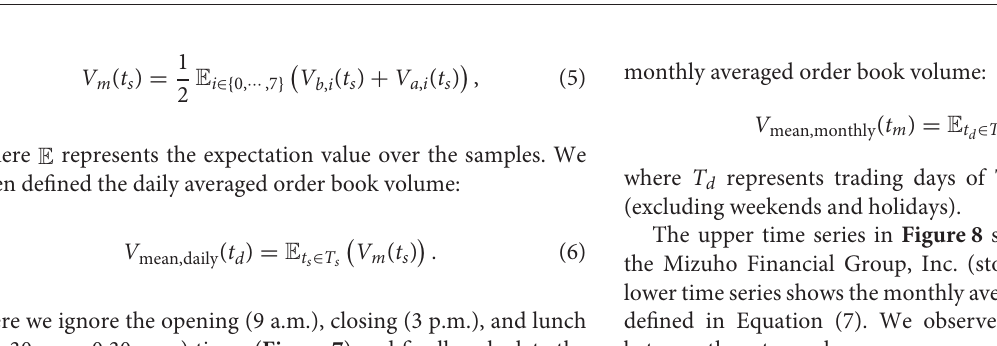
FIGURE 8 | Time series of monthly gradient ( α * i ) of Mizuho Financial Group, Inc. (stock code: 8411) and averaged order book volume ( V mean,monthly ) for a 29-month period from August 2014 to December